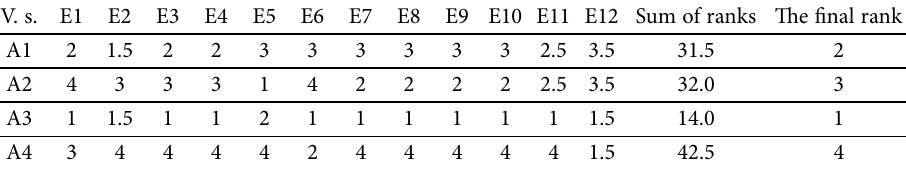
Table 2. Ranking factors in the group of the situation on the market regarding the commercial potential of